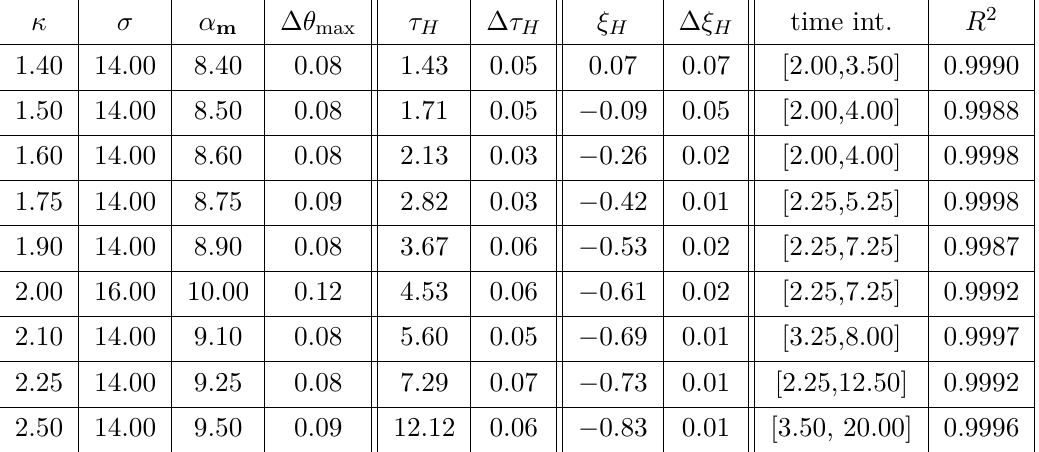
+ ξ for various κ and T = 0 . The fitting H a τ H indicates the best rapidity max ∆ τ and ξ ∆ ξ correspond to the 95% -confidence bounds of the two H ± H H ± H are fitted in figure 8 with fit parameters shown in table 9. H